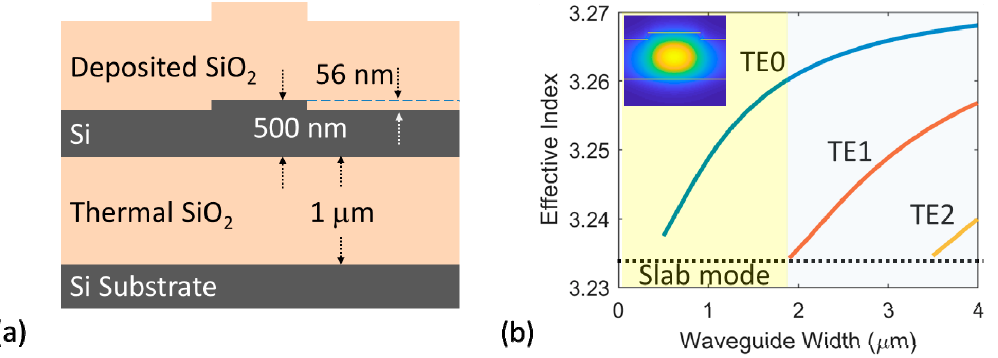
Figure 2. ( a ) Cross-sectional geometry of the ultra-low loss (ULL) Si waveguides in this work. The thickness of the buried oxide (BOX) and the Si device layer are 1 µm and 500 nm, respectively. The 56 nm tall Si rib is formed by dry-etching, leaving a 444 nm thick Si slab. ( b ) Effective index versus waveguide width in the 56 nm rib Si waveguide. The waveguide is quasi-single mode within the yellow colored region. Inset: Electric field profile of the fundamental mode in 1.8 µm wide waveguide.